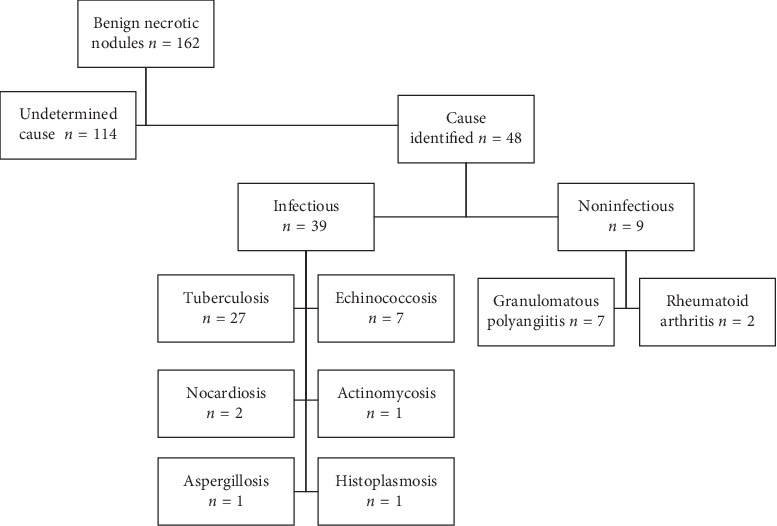
The study population.